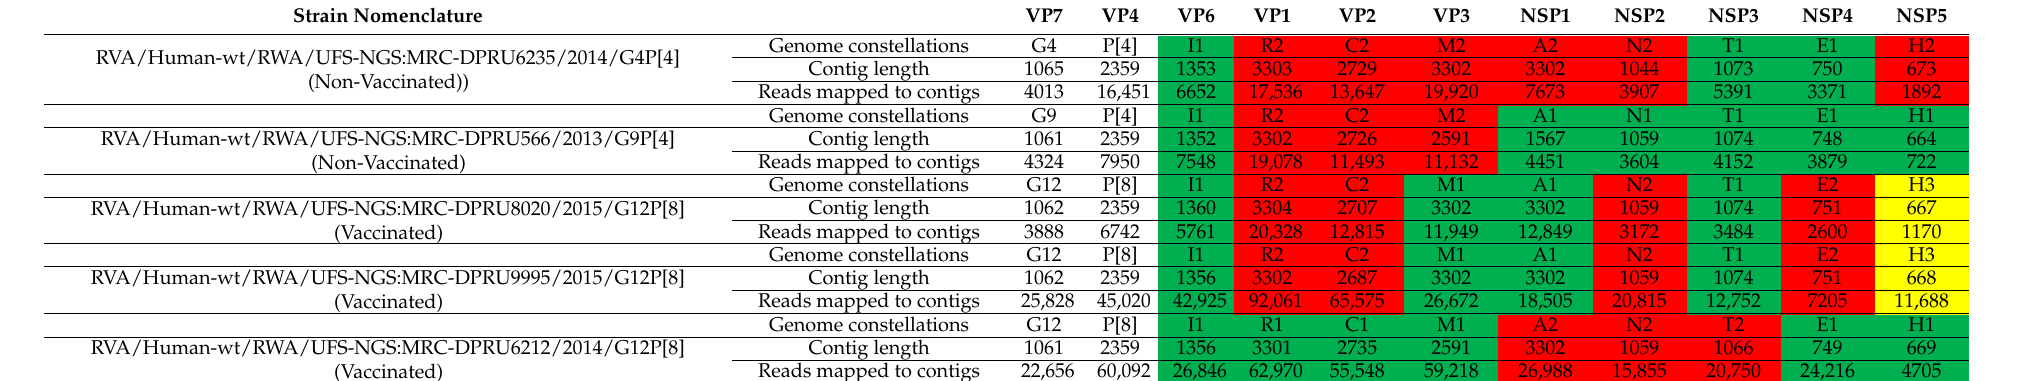
Table 1. Genome constellations of five reassortant rotavirus strains detected post-vaccine introduction (2013–2015) in Rwanda along with the contigs length and number of reads mapped to each